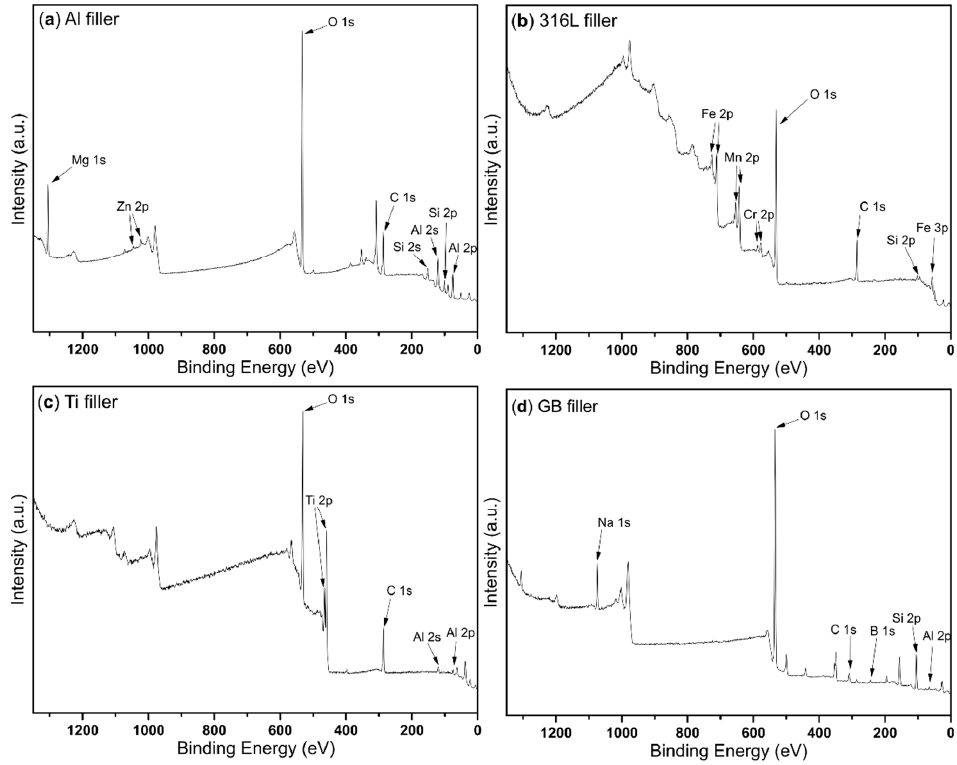
Figure 9. XPS survey spectra with characteristic peaks for the fillers: ( a ) Al, ( b ) 316L, ( c ) Ti, and ( d ) GB. Table 5. Elemental composition of the surface of the fillers measured by XPS.